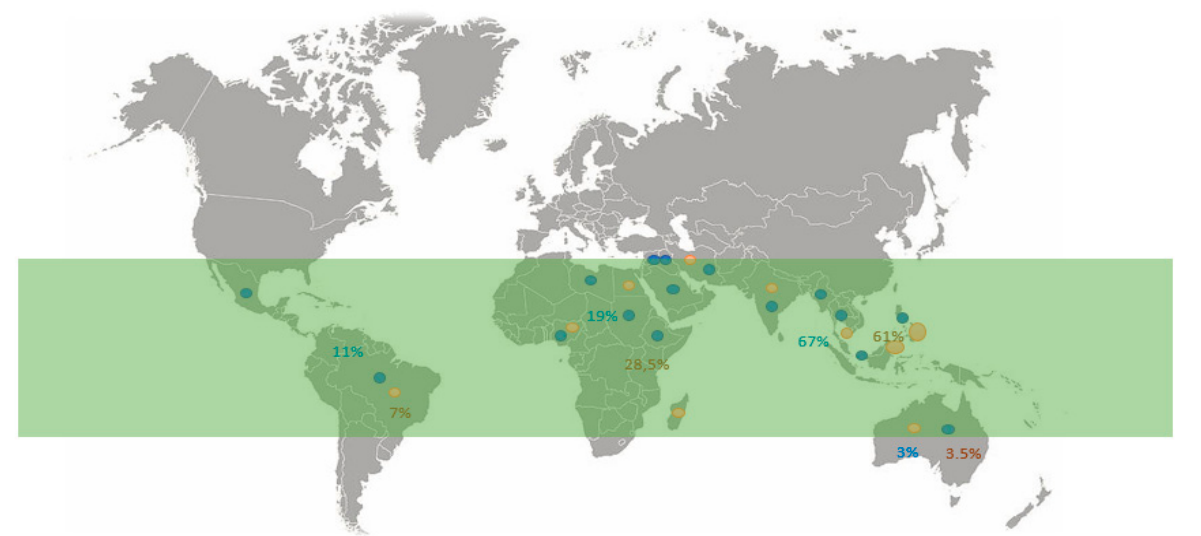
Figure A1. Map of the world indicating the tropical countries and sample locations where the blue circle are indoor air quality and the yellow for the thermal comfort studies.